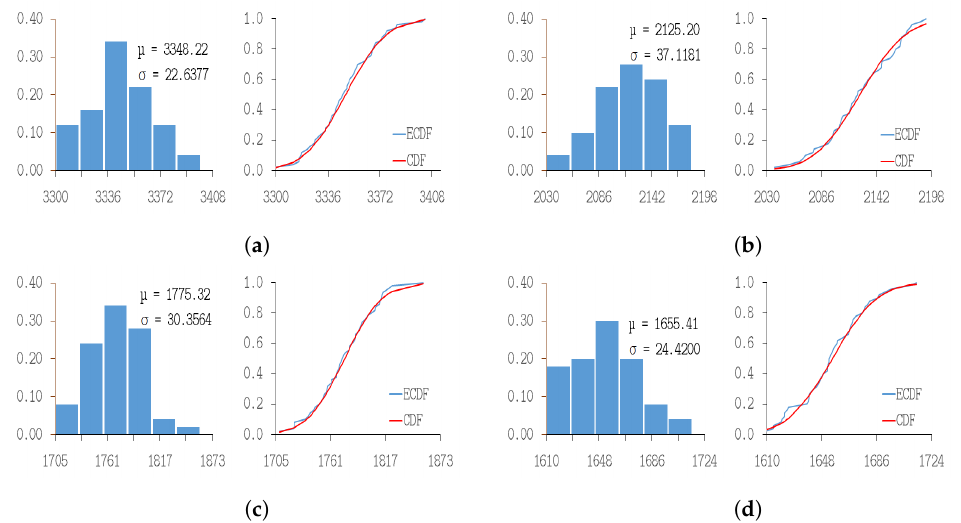
Figure 15. Simulation results from the scenarios of zone 3. ( a ) Scenario 6. ( b ) Scenario 7. ( c ) Scenario 8. ( d ) Scenario 9. Table 6. Simulation